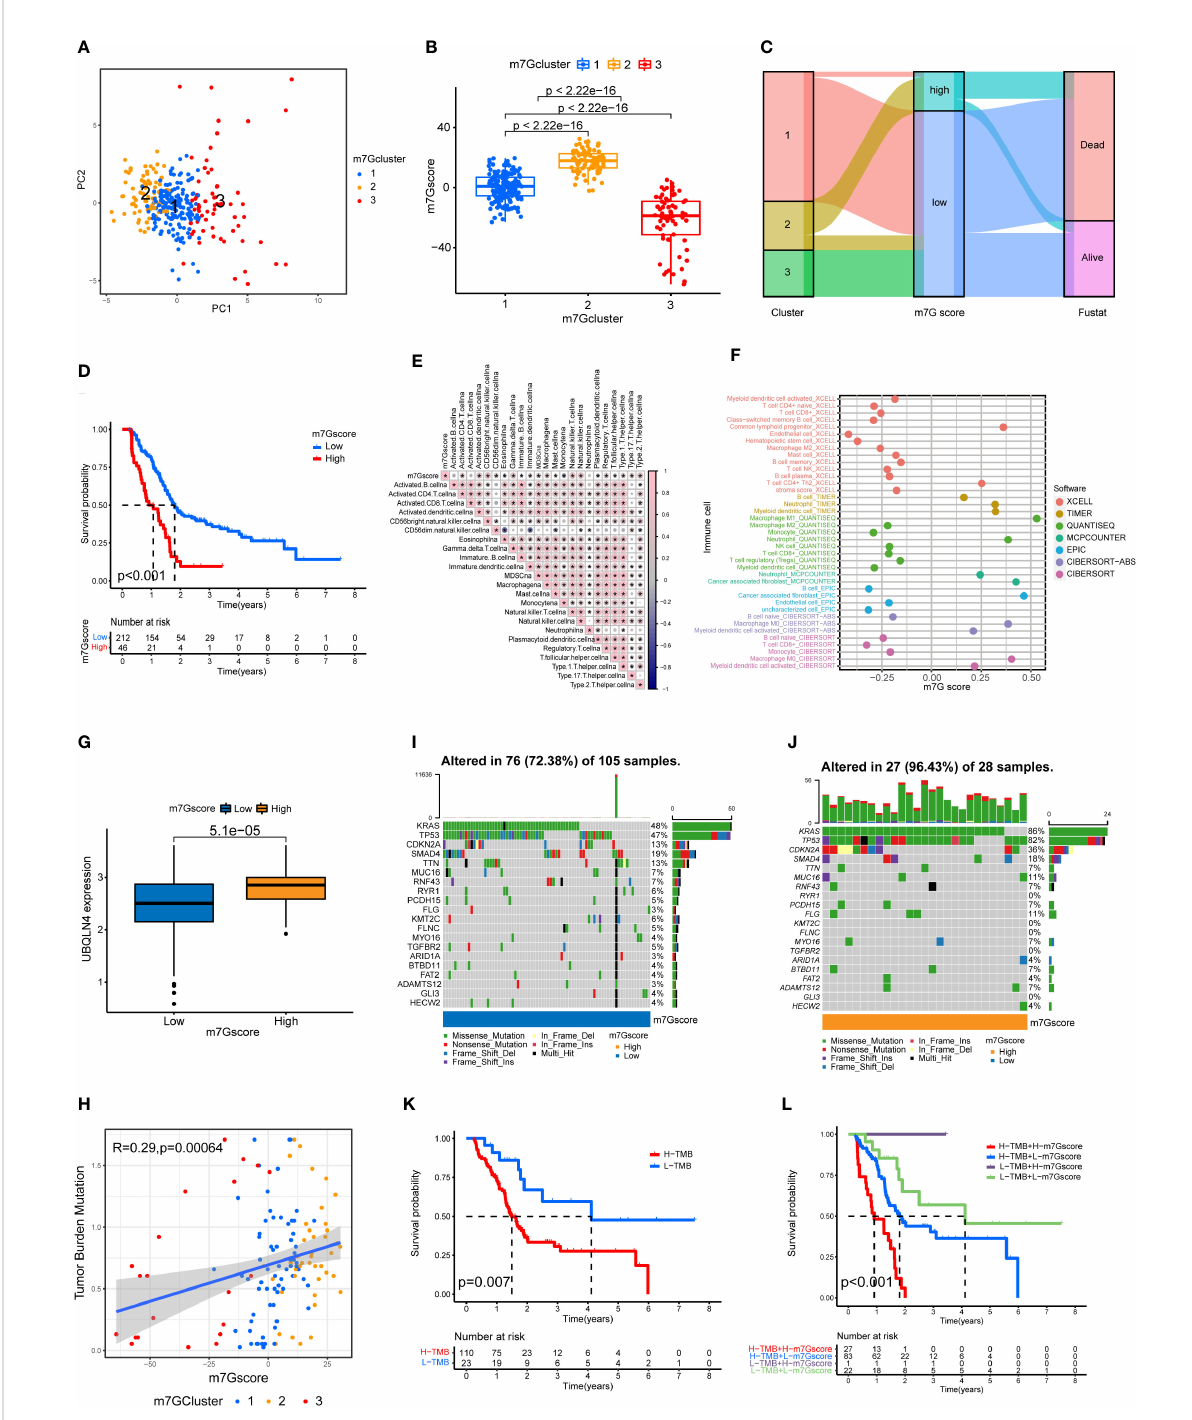
FIGURE 3 Immune cell in fi ltration and genomic instability in the m7G score. (A) PCA of the m7G methylation genes. (B) The m7G scores for the three clusters of pancreatic cancers. (C) The Sankey plots revealed the correlation results of m7G clusters, m7G scores and the future state of patients. (D) Kaplan – Meier survival curves of the high m7G score group and the low m7G score group. (E) Spearman correlation analysis of the relationship between m7G scores and immune cell types *p<0.05. (F) Correlation of m7G score and immune cell in fi ltration through multiple software. (G) UBQLN4 expression in the high m7G score group and the low m7G score group. (H) Correlation analysis of the relationship between m7G scores and tumor mutation burden among the three clusters of PDAC. (I, J) Waterfall plot of gene mutation frequencies for low and high m7G score groups. (K) Kaplan – Meier survival curves of the high tumor mutation burden group and the low tumor mutation burden group. (L) Combined survival analysis results for the high and low tumor mutation burden groups and the high and low m7G score